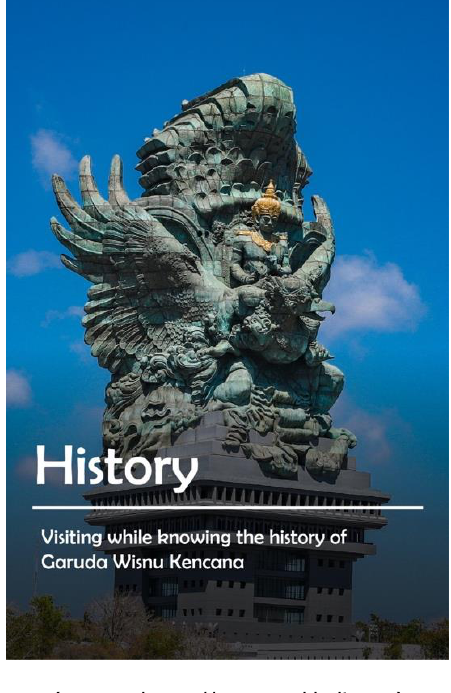
Figure 1. Garuda Wisnu Kencana